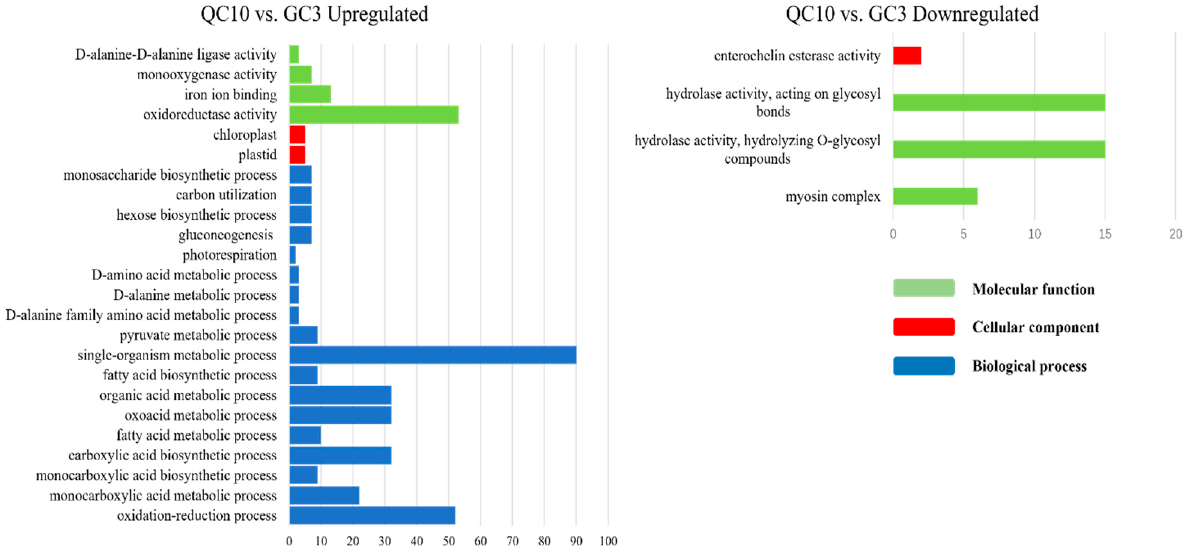
Figure 4. GO annotation of differentially expressed genes (DEGs) in the QC10 vs. GC3 comparison. The blue, red, and green columns represent the biological process (BP), cellular component (CC), and molecular function (MF), respectively.